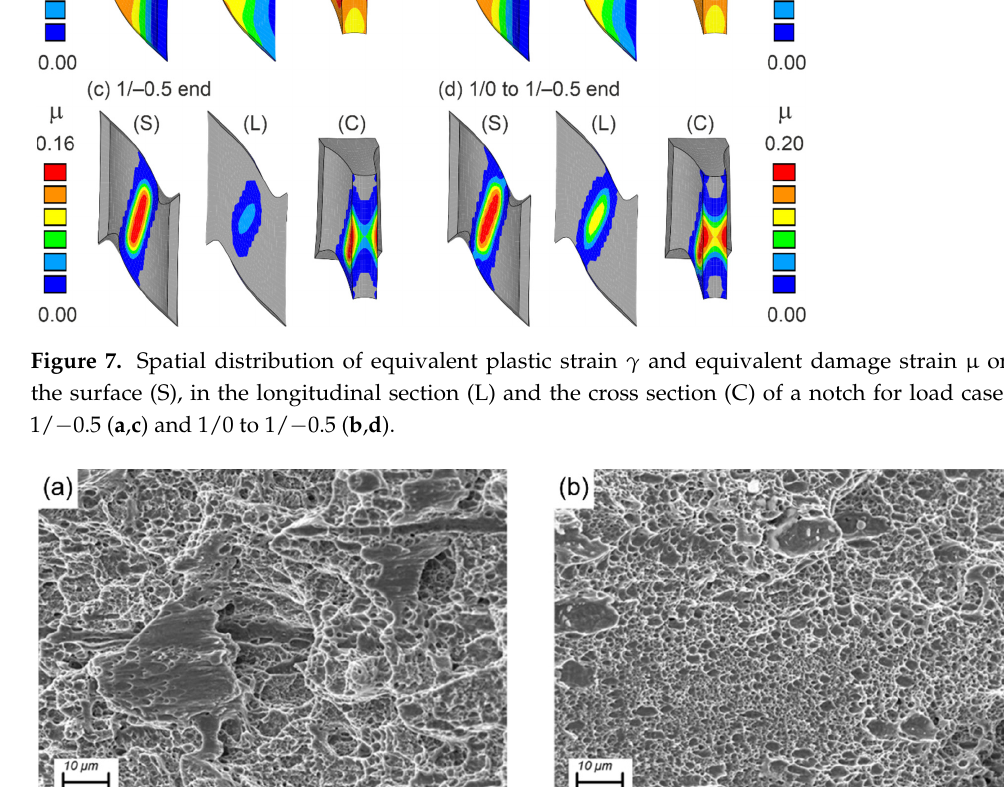
Figure 7. Spatial distribution of equivalent plastic strain 𝛾 and equivalent damage strain μ on the surface (S), in the longitudinal section (L) and the cross section (C) of a notch for load cases 1/ − 0.5 ( a , c ) and 1/0 to 1/ − 0.5 ( b , d ).